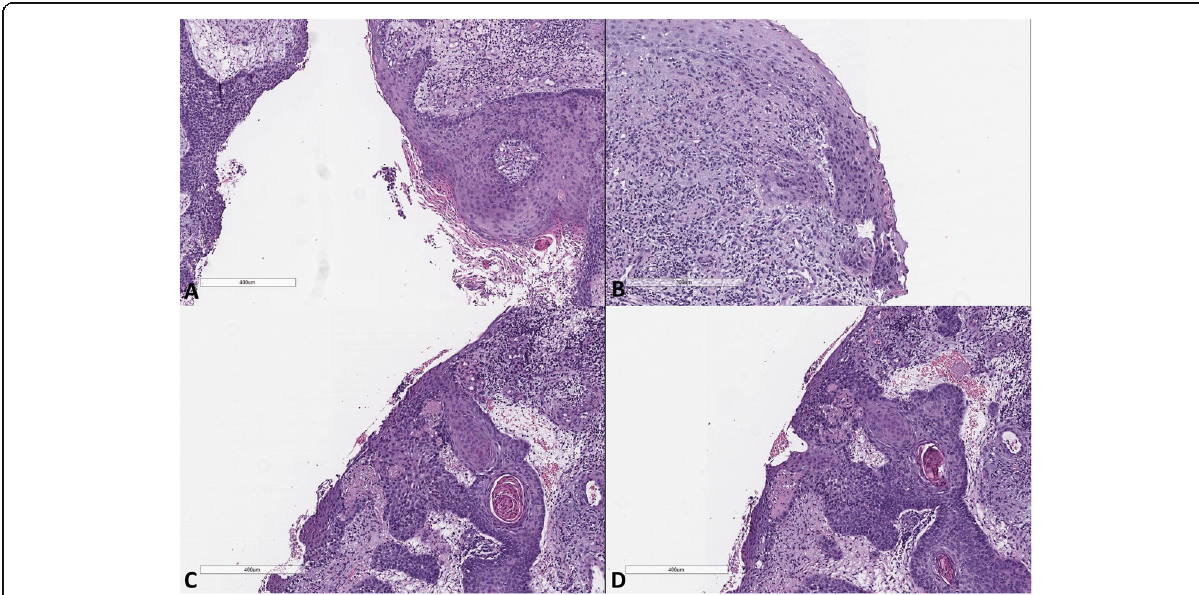
Fig. 2 H&E stain demonstrating the variable histological features of the cancer involving the surface epithelium of the nipple ( a - d ). The mucosal cells are enlarged, hyperchromatic and dysplastic